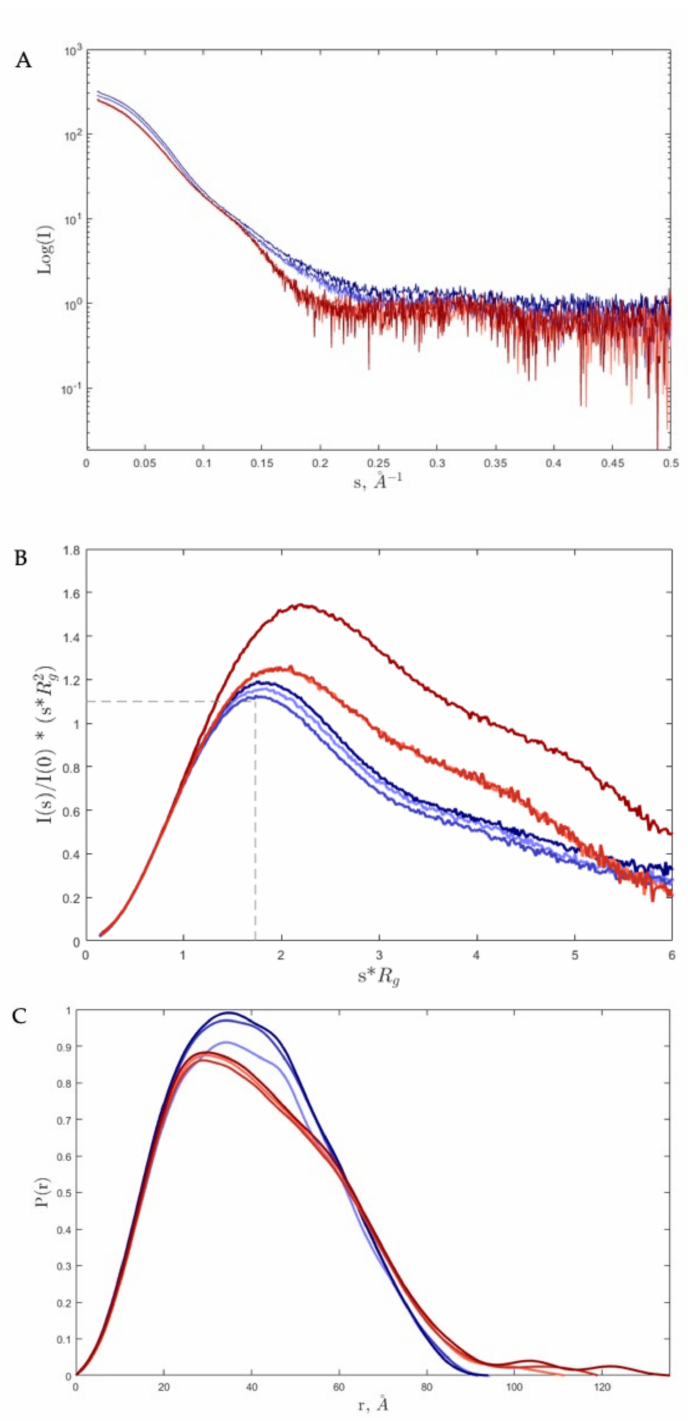
Figure 1. ( A ). Log10 SAXS intensity versus scattering vector, s. The plotted range represents only positive data within the specified s-range. ( B ). Dimensionless Kratky plot. The maximum value (intersection of dashed black lines) at Guinier–Kratky point (1.732, 1.1) corresponds to the main peak position for globular particles. ( C ). Pair-Distance, P(r), Distribution Function. The maximum dimension, D max , is the largest non-negative value that supports a smooth distribution function. The curves are overlapped; the red and blue curves correspond to iron-loaded transferrin (holo-Tf) and iron-free transferrin (apo-Tf), respectively. The color gradient for both from light to dark represents the change of pH from 8.0 to 5.5,